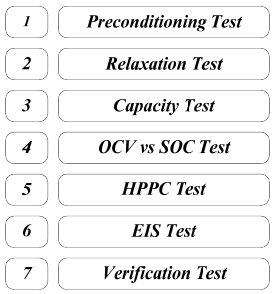
Figure 2. Test sequence for characterization of the LFP/C battery. OCV : open-circuit voltage; SOC : state-of-charge; and HPPC: hybrid pulse power characterization.